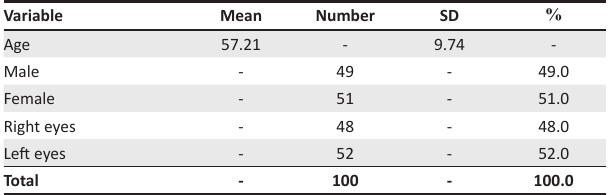
TABLE 1: Basic characteristics of study